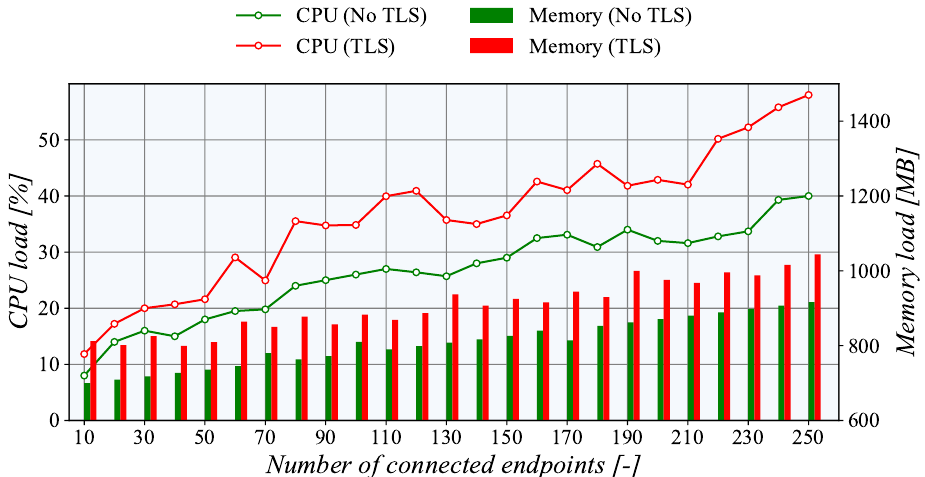
Figure 14. Utilization of system resources on the generator side in a PULL